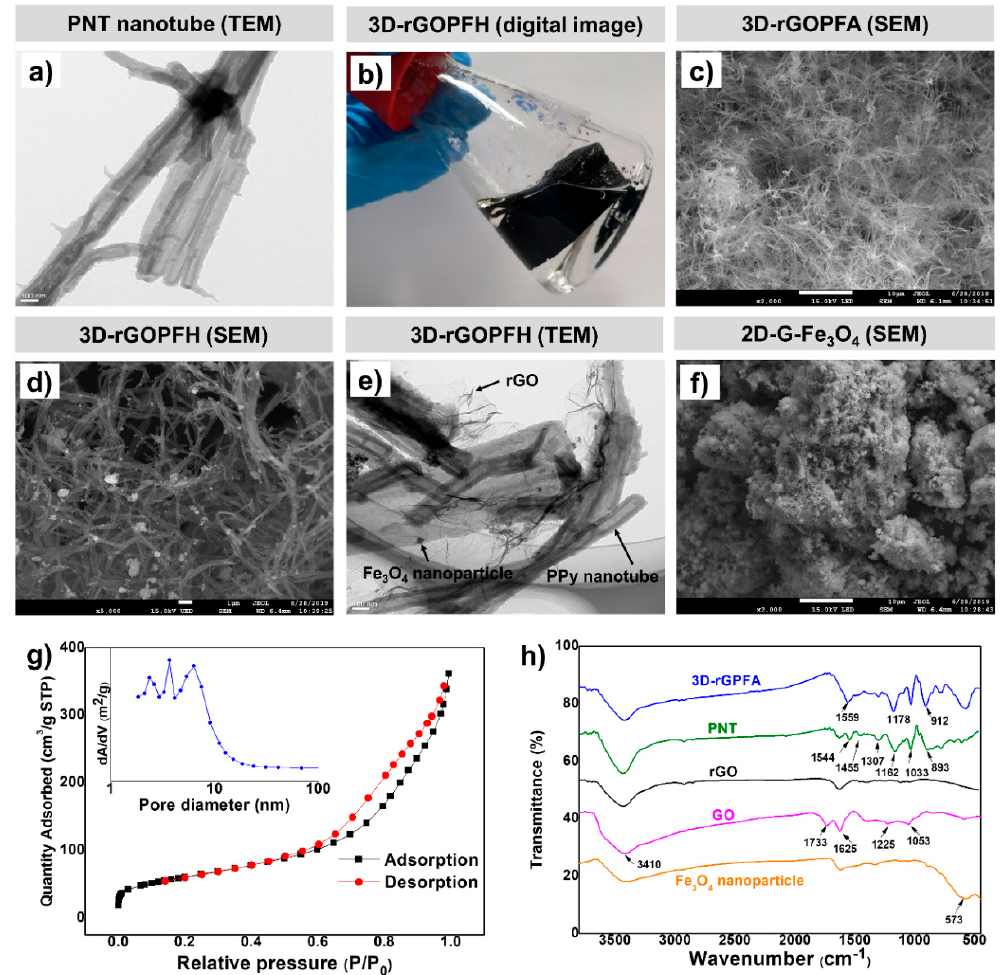
Figure 2. ( a – f ) The morphologies of the as-prepared materials were observed using SEM, TEM, and digital camera. ( g ) The nitrogen adsorption-desorption isotherm and pore size distribution analysis 3D-rGOPFH. ( h ) FT-IR spectra of GO, rGO, PNT, Fe 3 O 4 nanoparticles and of 3D-rGOPFH. ( h ) FT-IR spectra of GO, rGO, PNT, Fe 3 O 4 nanoparticles and 3D-rGOPFH.